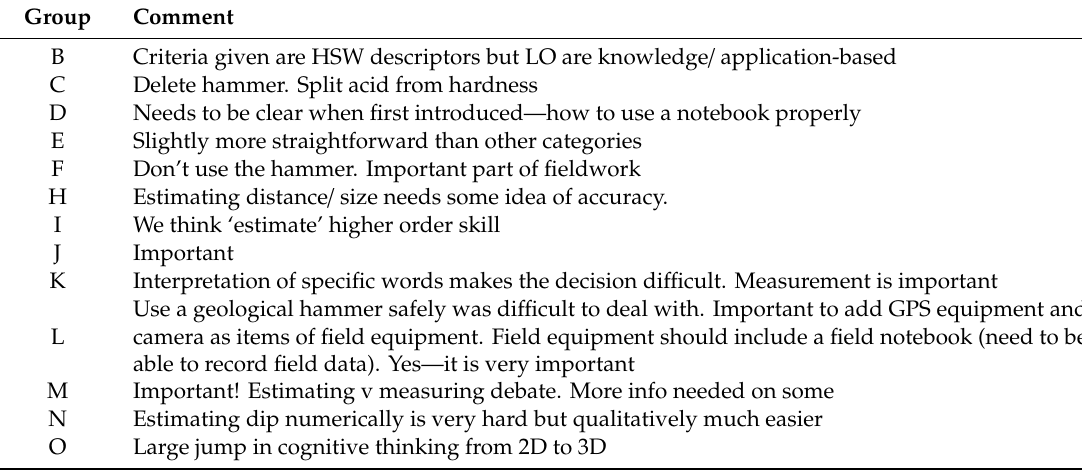
Table A2. Use field equipment accurately.